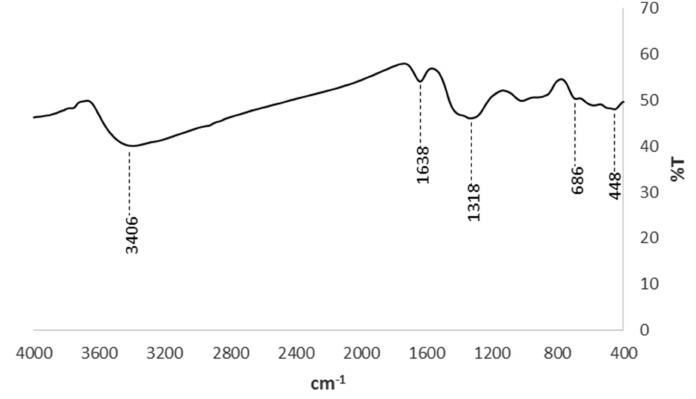
Figure 4. FTIR of iron oxide nanoparticles. Table 1 represents the chemical composition of the IONPs in weight percent. The species with the highest composition is Fe 2 O 3 , followed by SiO 2 . Thus, Fe 2 O 3 is the major element of the synthesised